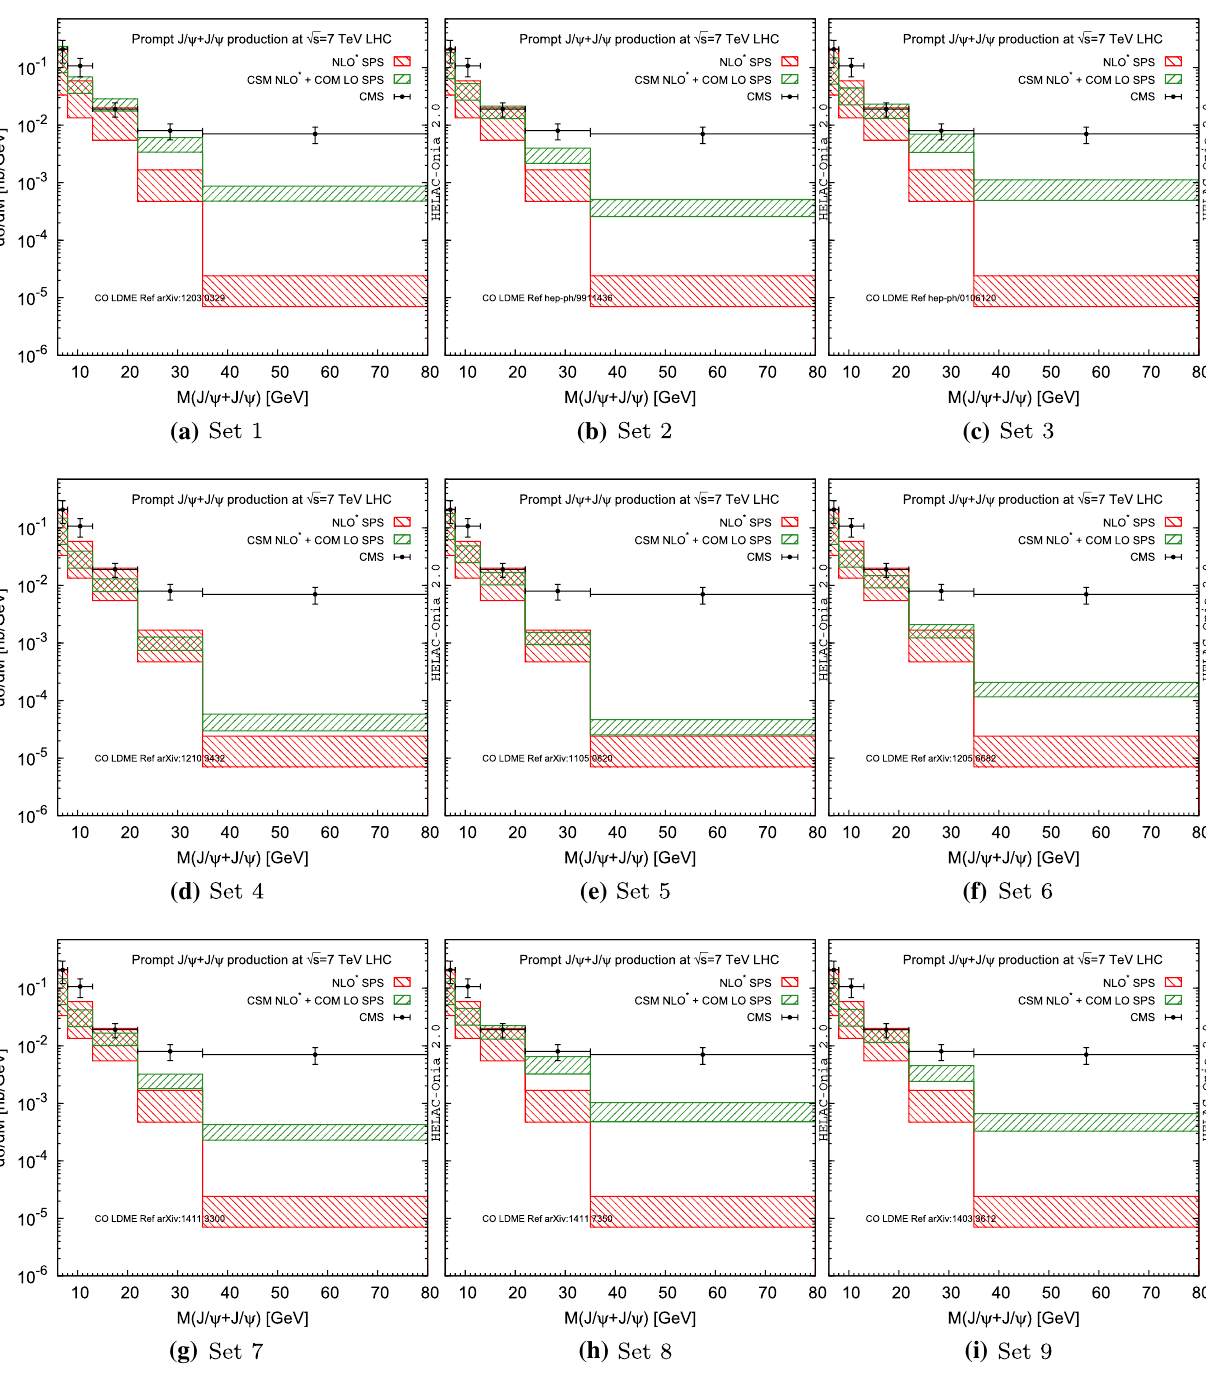
Fig. 7 M ( J /ψ, J /ψ) distributions in NLO (cid:11) CS and LO CO via SPS within CMS